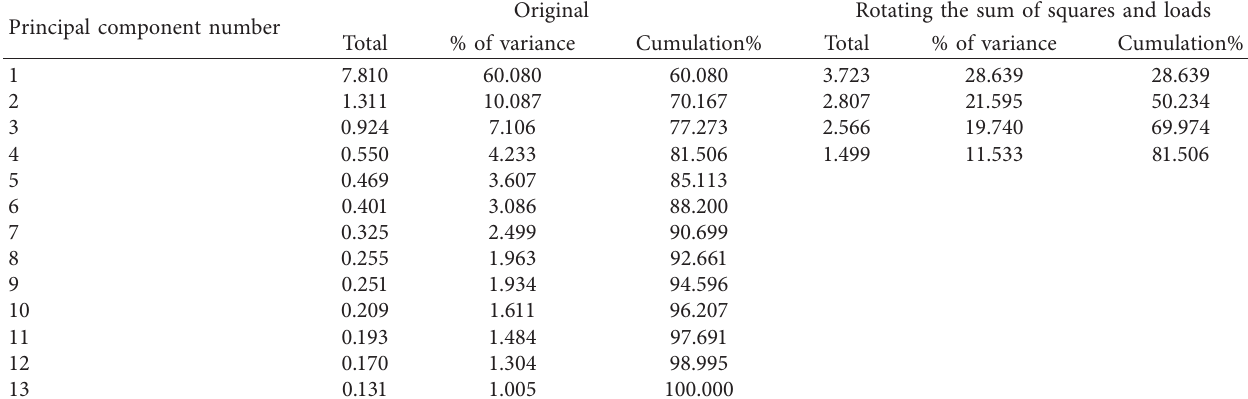
Table 6: Principal component information.